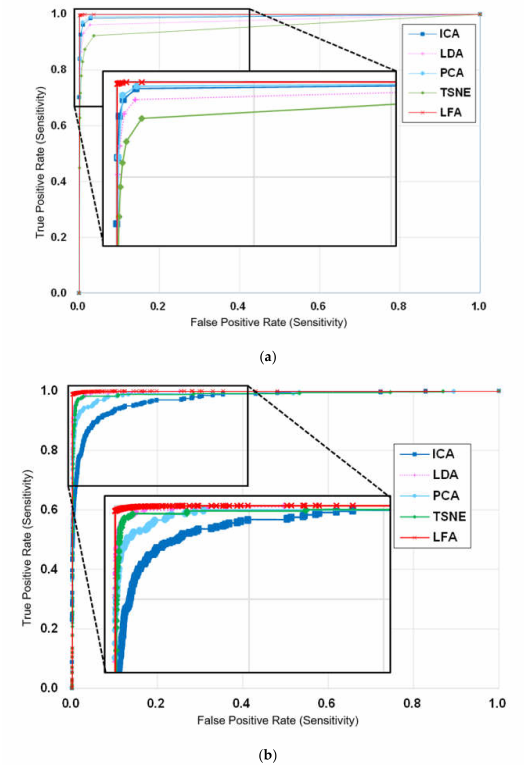
Figure 14. Receiver operating characteristic (ROC) curve by the feature extraction algorithm. ( a ) ROC curve using k-nearest neighbors. ( b ) ROC curve using a support vector